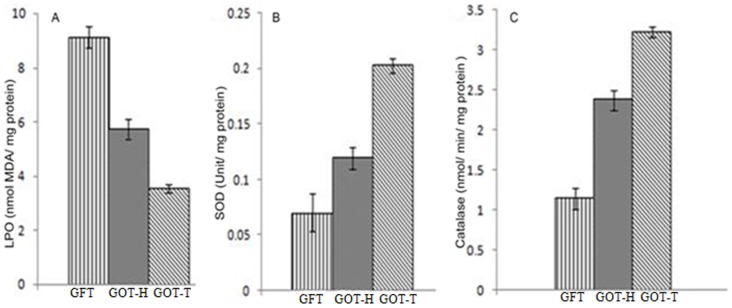
Ovarian oxidative stress markers.Data demonstrate that the generation of malondialdehyde (MDA) that marks lipid peroxidation (Fig. 8A) is significantly lower, and the ovarian SOD (Fig. 8B) and catalase activity (Fig. 8C) are markedly higher in both the host (GOT-H) as well as transplanted ovary (GOT-T) of the GOT group, as compared to that of the fat transplanted group (GFT). Results are expressed as mean ±SEM of five independent determinations. For all parameters, GOT-H vs. GFT: P<0.05, GOT-T vs. GFT: P<0.001.